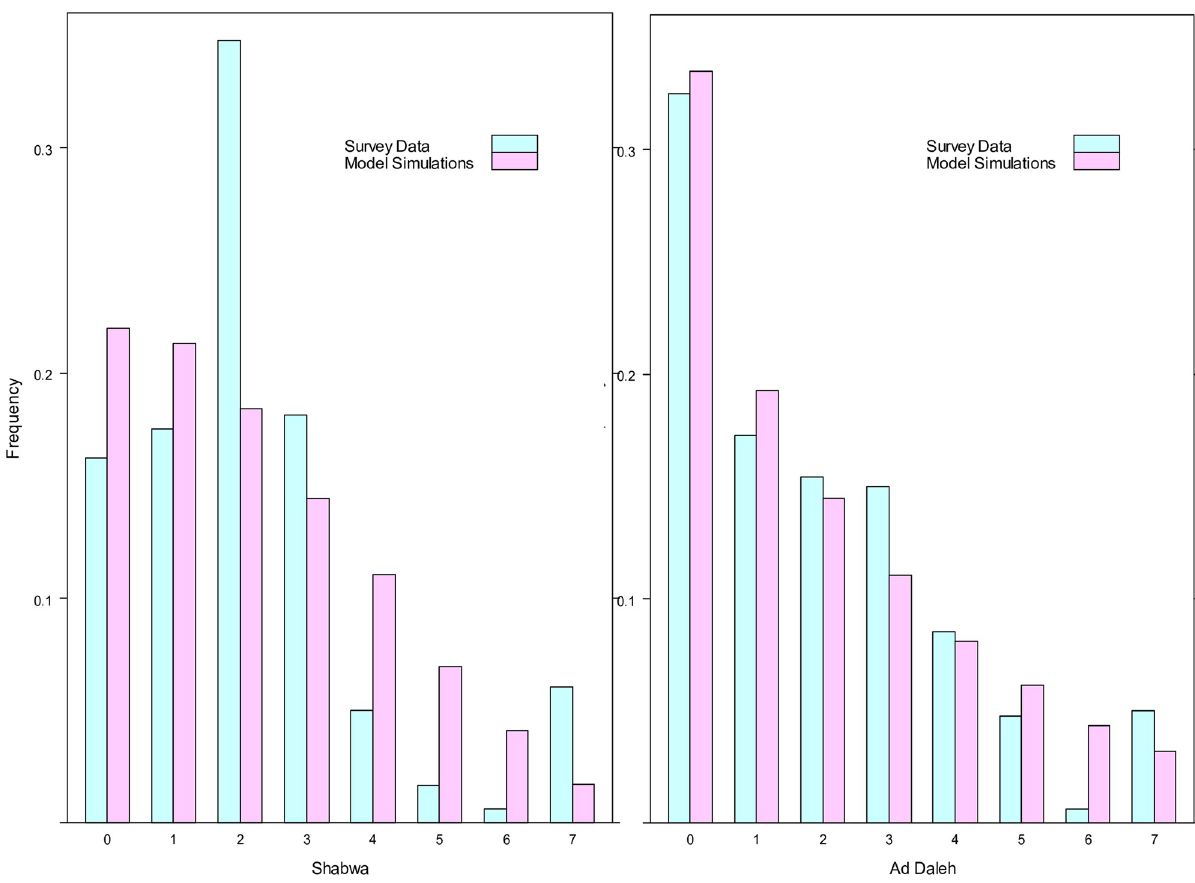
Fig 1. Empirical distributions and fitted beta-binomial models for vegetable